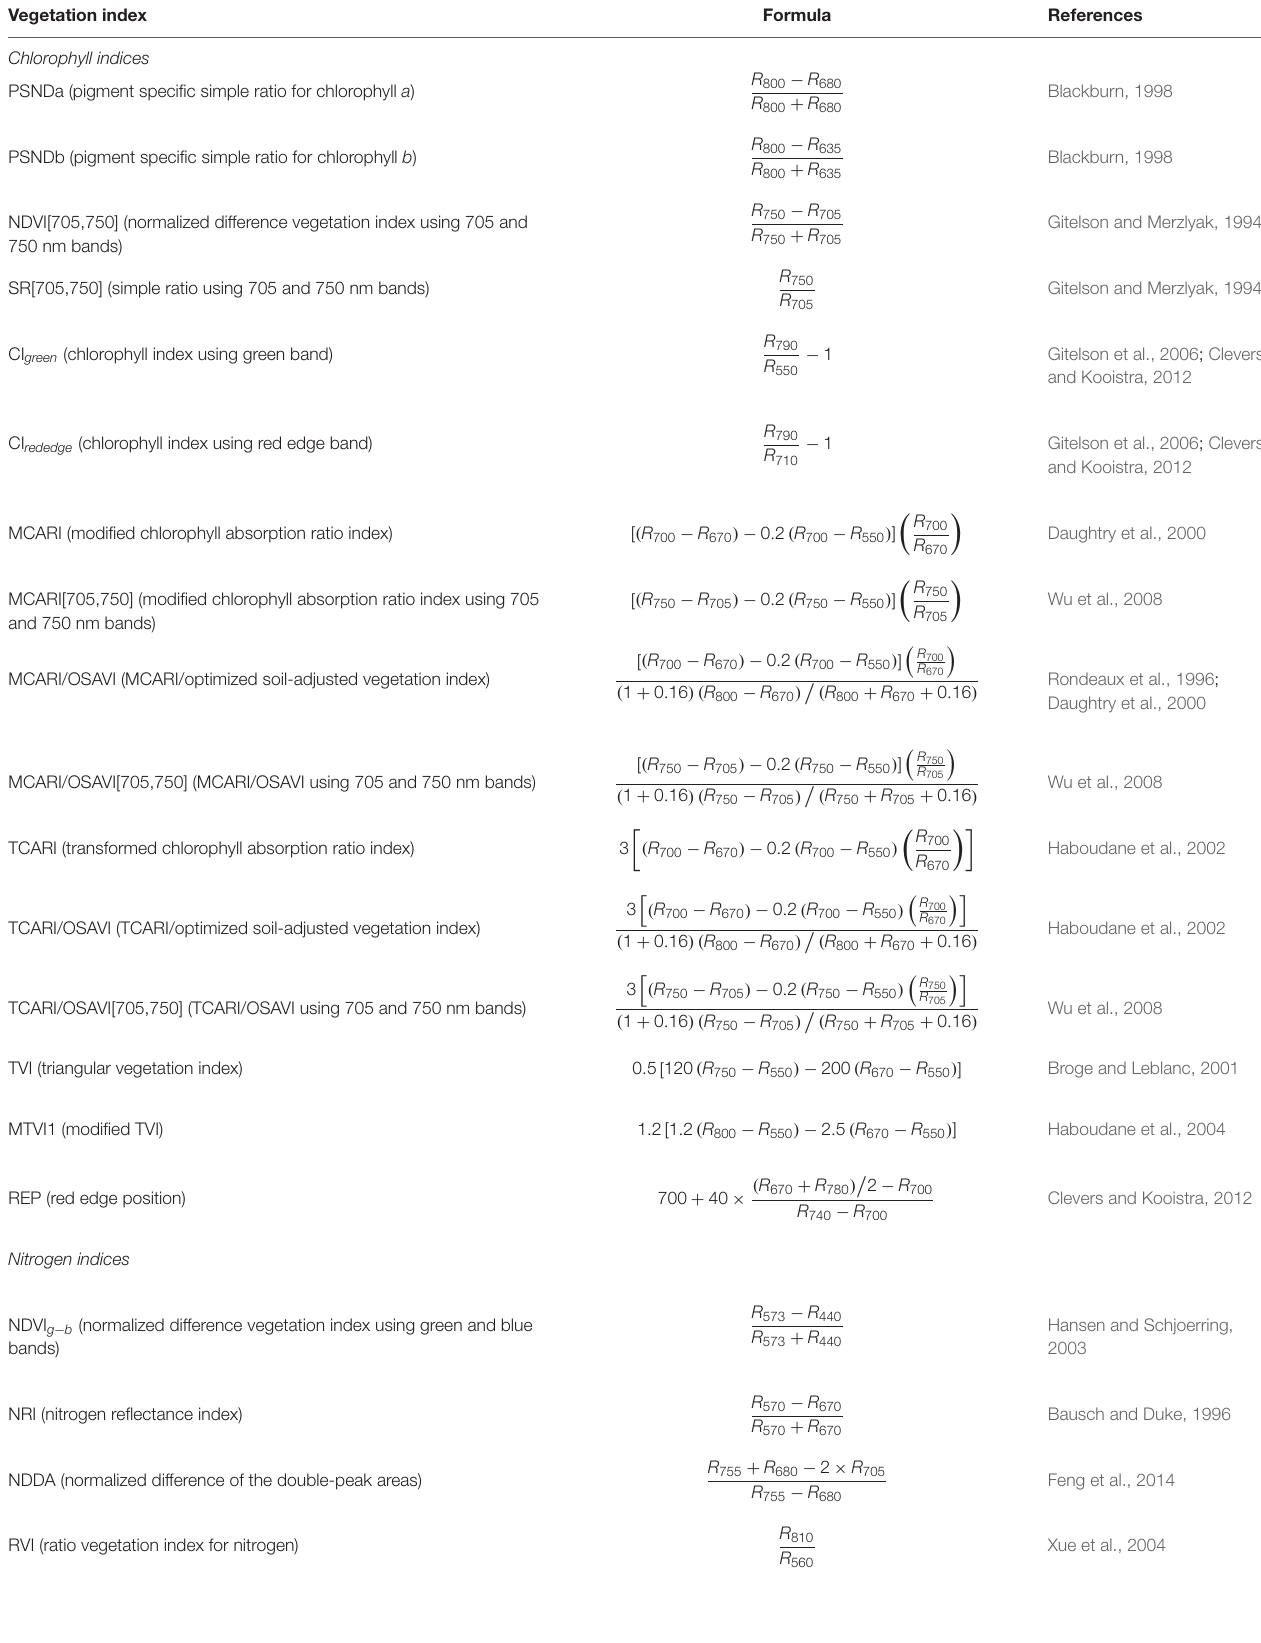
TABLE 3 | Published vegetation indices used in the